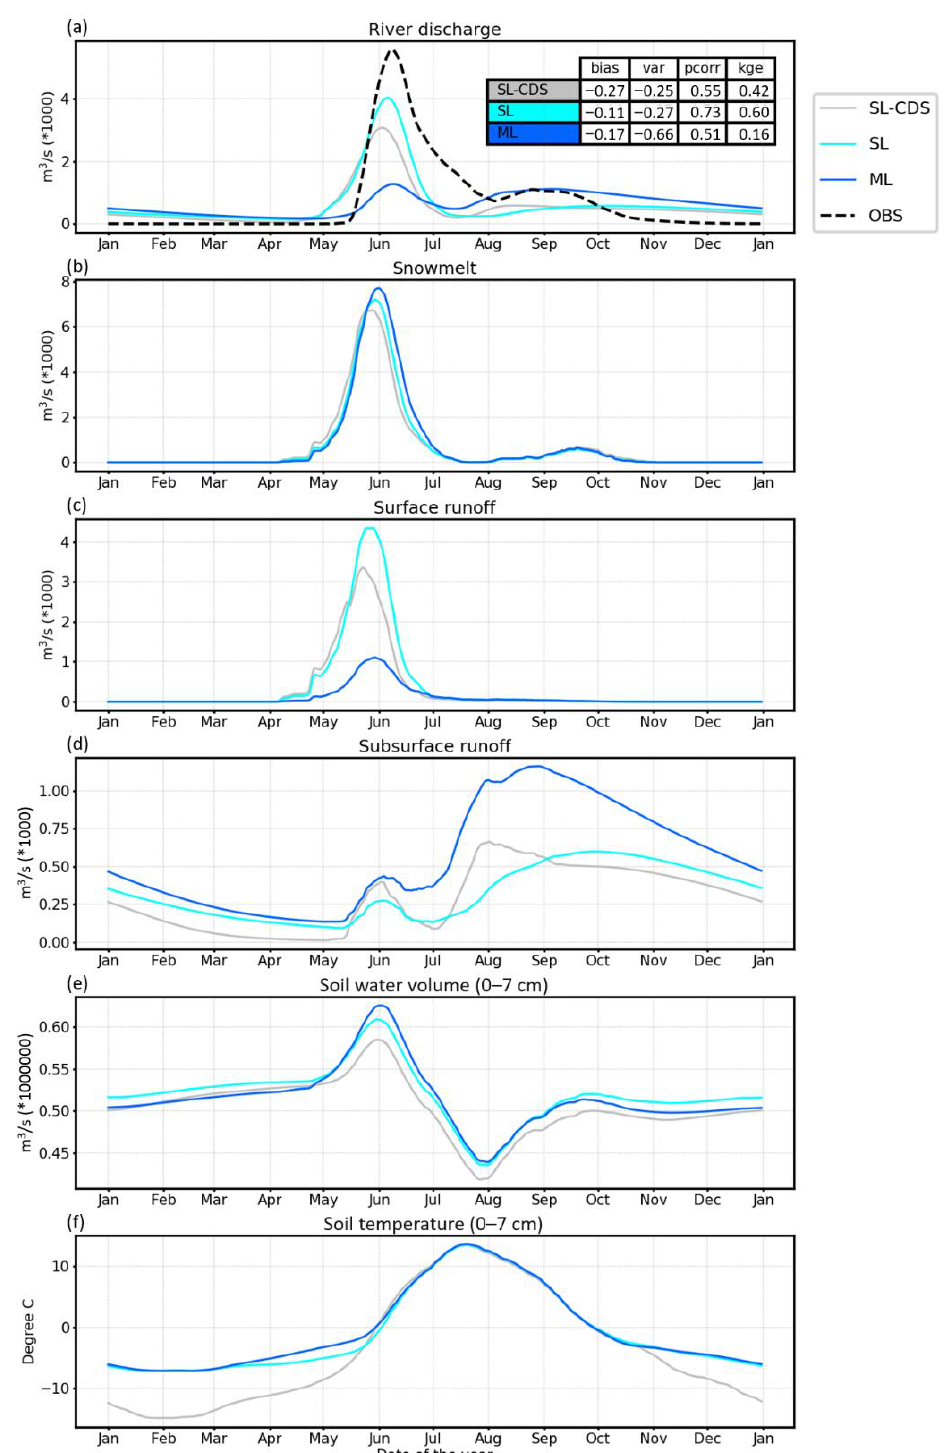
Figure 4. Daily climatological mean time series of ( a ) river discharge, ( b ) snowmelt, ( c ) surface runoff, ( d ) subsurface runoff, ( e ) water content and ( f ) temperature in the top 7 cm of the soil from SL-CDS, SL and ML experiments for the Olenek river at the station of Sukhana in eastern Siberia (with area of 127,000 km 2 ). All water related variables are displayed as catchment totals in order to compare them directly to river discharge, while for soil temperature catchment averages are shown (please note the values are divided by 1000 for river discharge, snowmelt and subsurface runoff and by 1,000,000 for soil water volume). The kge and its bias , var and pcorr component scores are provided in an inset table for river